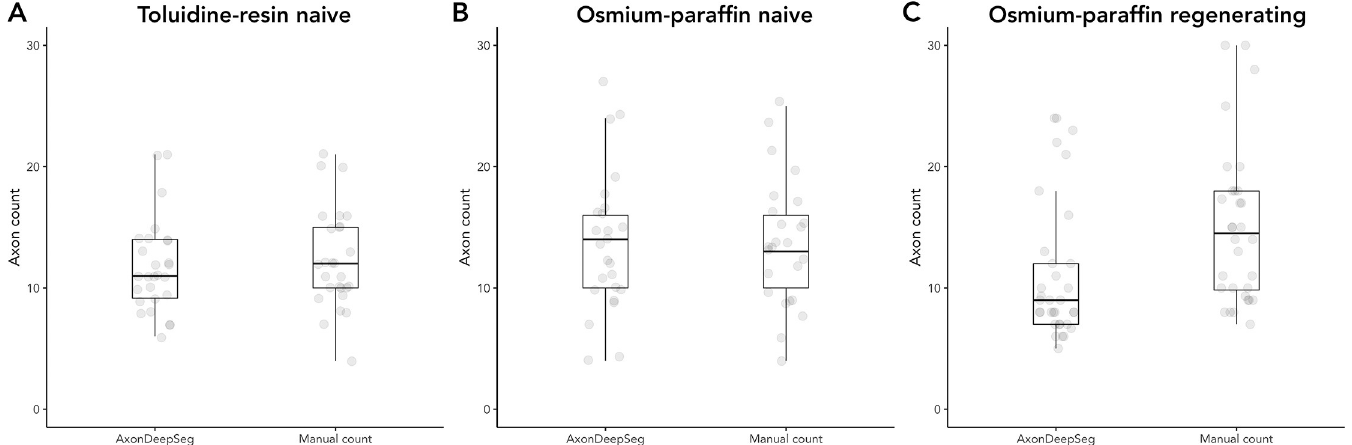
Fig 3. Number of axons in the sampled area. (A) Na ï ve nerves prepared with the toluidine-resin protocol, the mean number of axons in the 625 μ m 2 sample area for the 27 micrographs. (B) Na ï ve nerves prepared with the osmium-paraffin protocol, the mean number of axons in the 625 μ m 2 sample area for the 27 micrographs. (C) Regenerating nerves prepared with the osmium-paraffin protocol, the mean number of axons in the 1600 μ m 2 sample area for the 33 micrographs. Boxes are 1 interquartile range (IQR), whiskers 1.5 � IQR.